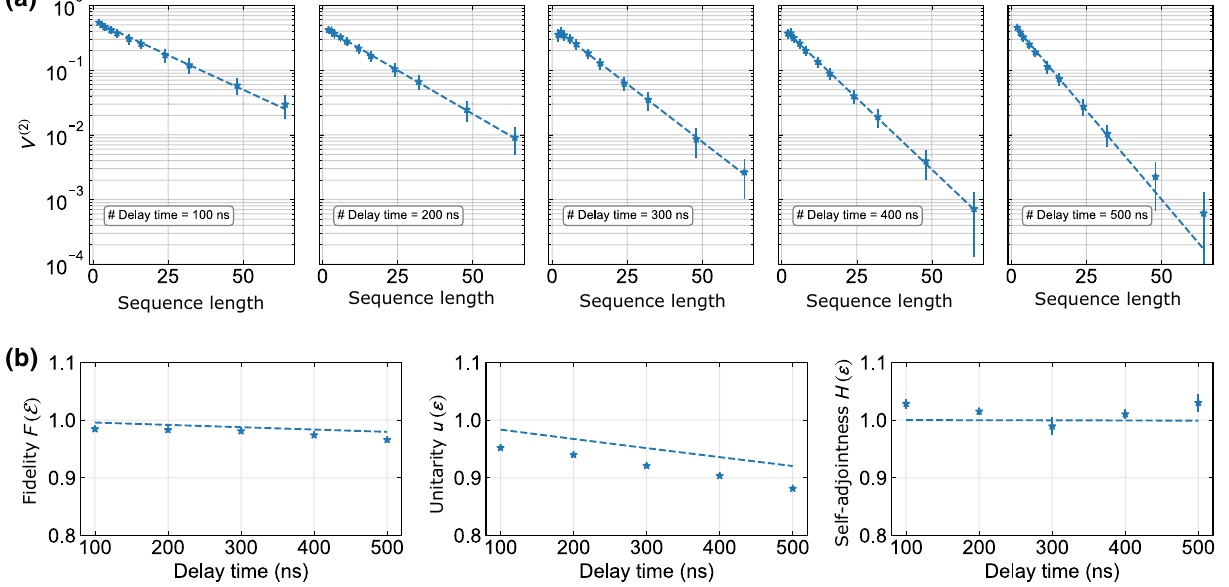
FIG. 4. (a) Experimental results for the single-qubit 2-RB on an isolated qubit when the interleaved delay times t are swept. We have taken 100 random unitary sequences from I × m for each sequence length m and have had 10 4 measurements for each sequence to obtain a data point of V ( 2 ) . The stars represent the values of V ( 2 ) and the dashed lines are fitting results. The error bars represent the standard deviation of V ( 2 ) . As the vertical axis of the figure is logarithmic notation, the error bars at the bottom of the figure are displayed larger. (b) Estimated values of F ( E t ) , u ( E t ) , and H ( E t ) obtained by the 2-RB. The stars show the fitting results, and the dashed lines are the predicted values from the phenomenological